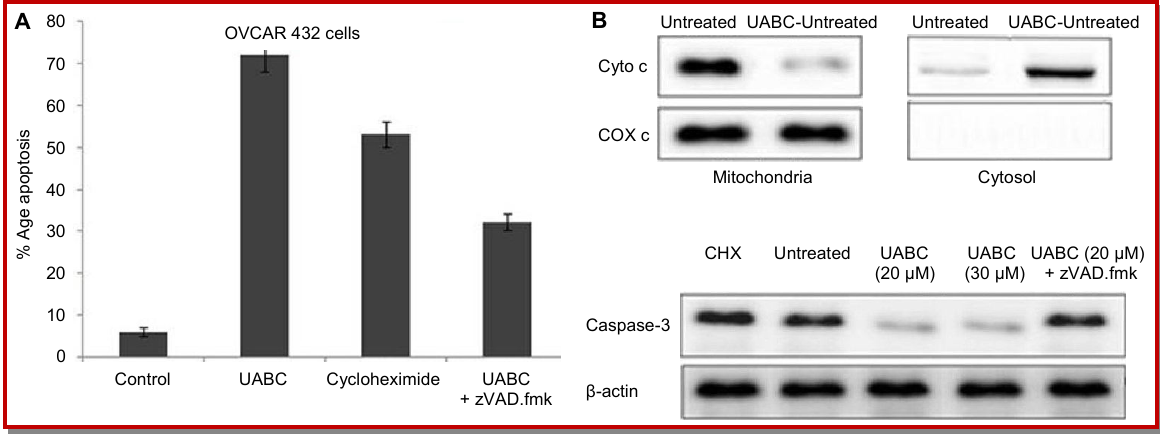
Figure 4: Effect of UABC on apoptosis in RMS cell lines. (A) The RMS cells were treated for 48 h with UABC in the presence or absence of 50 μ M of the zVAD.fmk. Apoptosis-specific DNA fragmentation was determined by FACS analysis of propidium io- dide-stained nuclei; 100 μ g/mL cycloheximide (CHX) was used as a positive control for apoptosis induction. (B) The RMS-13 cells were treated with UABC. Mitochondria were isolated, lysed, and the expression of cytochrome c and COX4 in the mitochondrial and cytosolic fraction was detected by western blot analysis. The RMS-13 cells were treated for 48 hours with UABC in the absence or presence of zVAD.fmk. Expression of caspase-3 and β - actin was detected by Western blot analysis. 100 μ g/mL